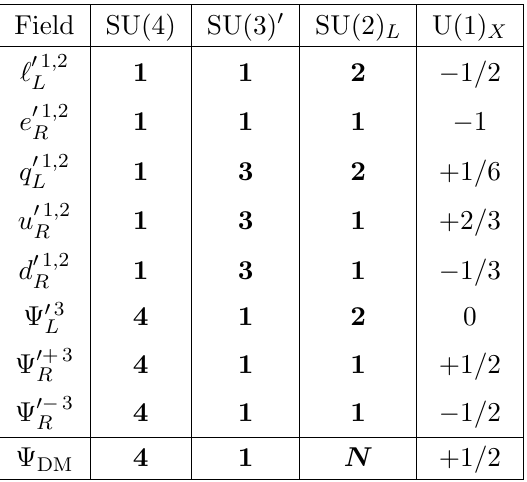
(cid:17) ( q 0 3 ‘ 0 3 ) | , L L L